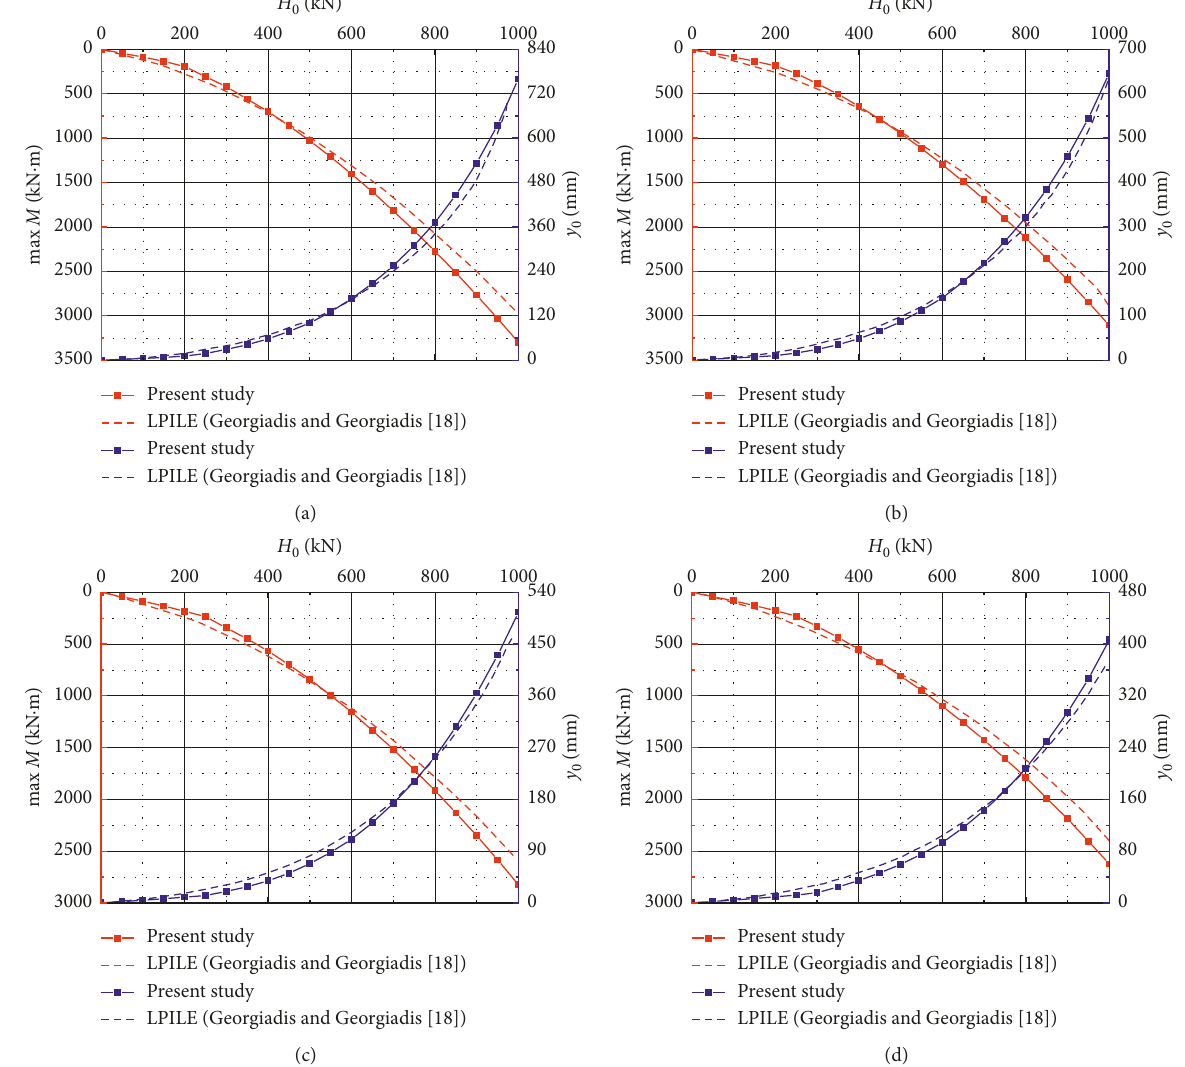
Figure 8: Verification analysis of H 0 - y 0 curves relationship for LPILE. (a) B (cid:31) 0.3 m, (b) B (cid:31) 0.6m, (c) B (cid:31) 1.2 m, (d) B (cid:31)